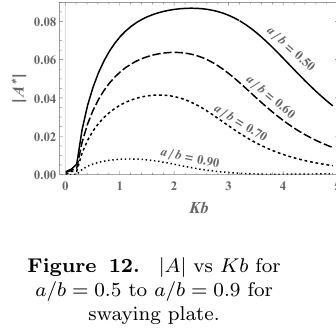
Figure 12. | A | vs Kb for a/b = 0 . 5 to a/b = 0 . 9 for swaying